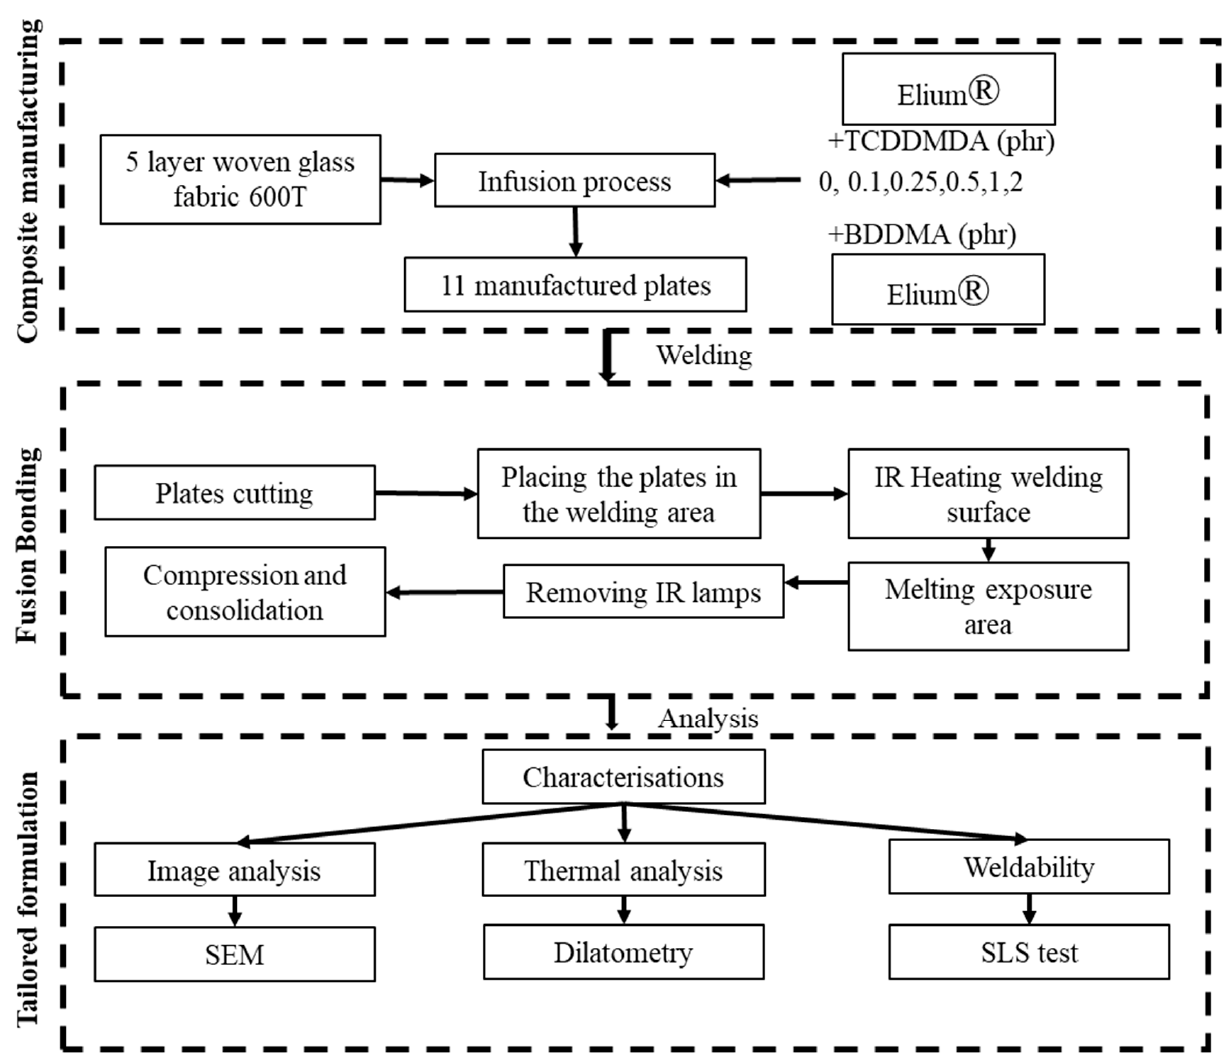
Figure 2. The experiment steps for the IR welding study of the modification of the Elium ® formula ‐ tion.